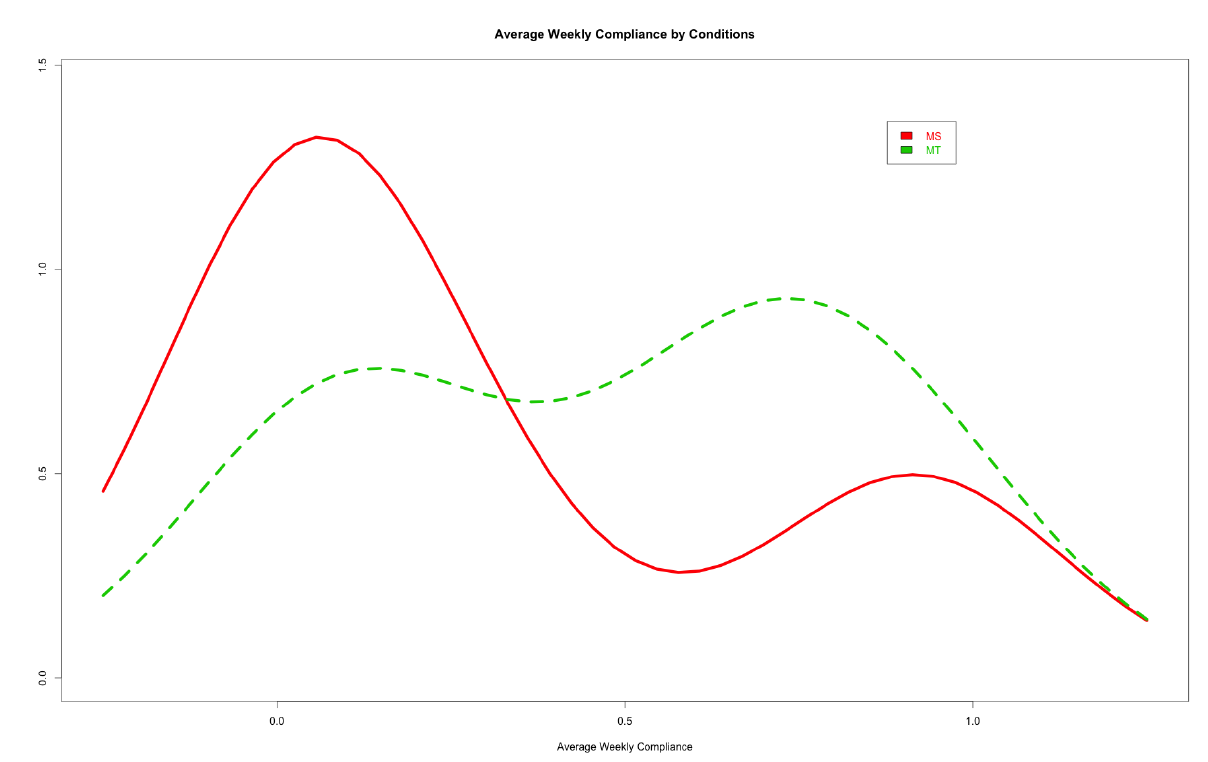
Figure 7. Kernel Density plots of average weekly compliance showing a bimodal distribution for both Mobile-Solo (Red) and Mobile-Team (Green) conditions.